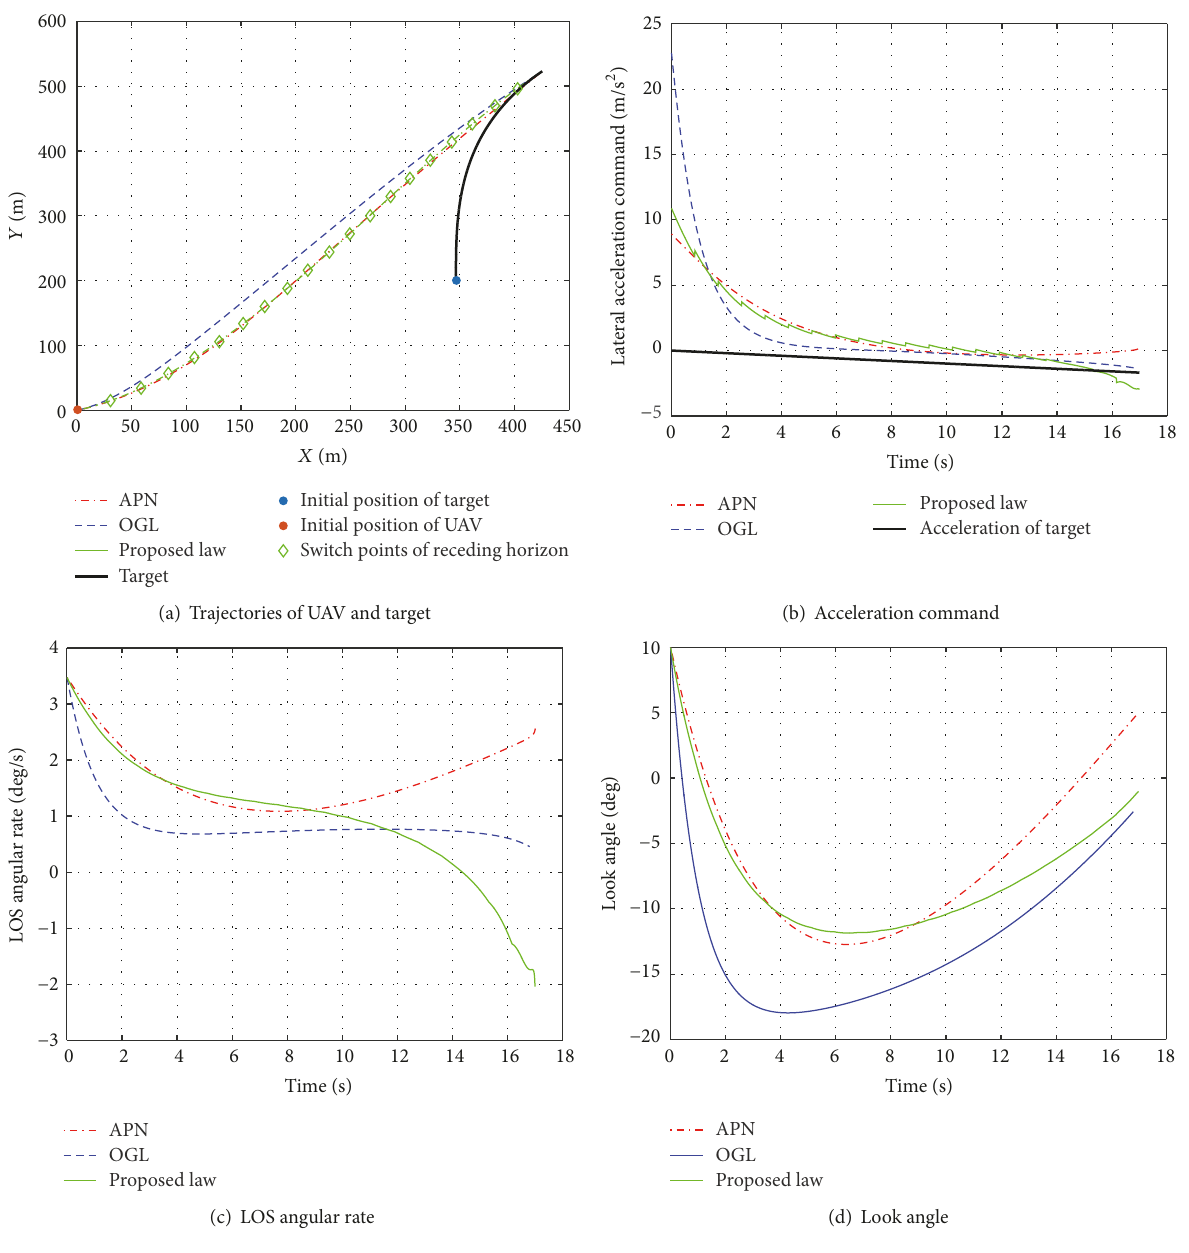
Figure 13: Responses in Case 2 (𝑎 𝑇 = −10 sin (0.01𝑡))